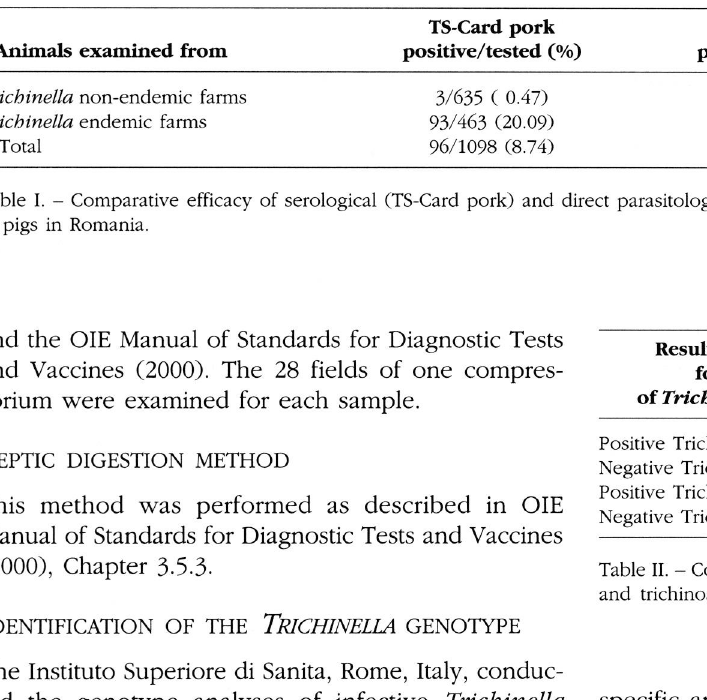
specific antibodies against Trichinella were not